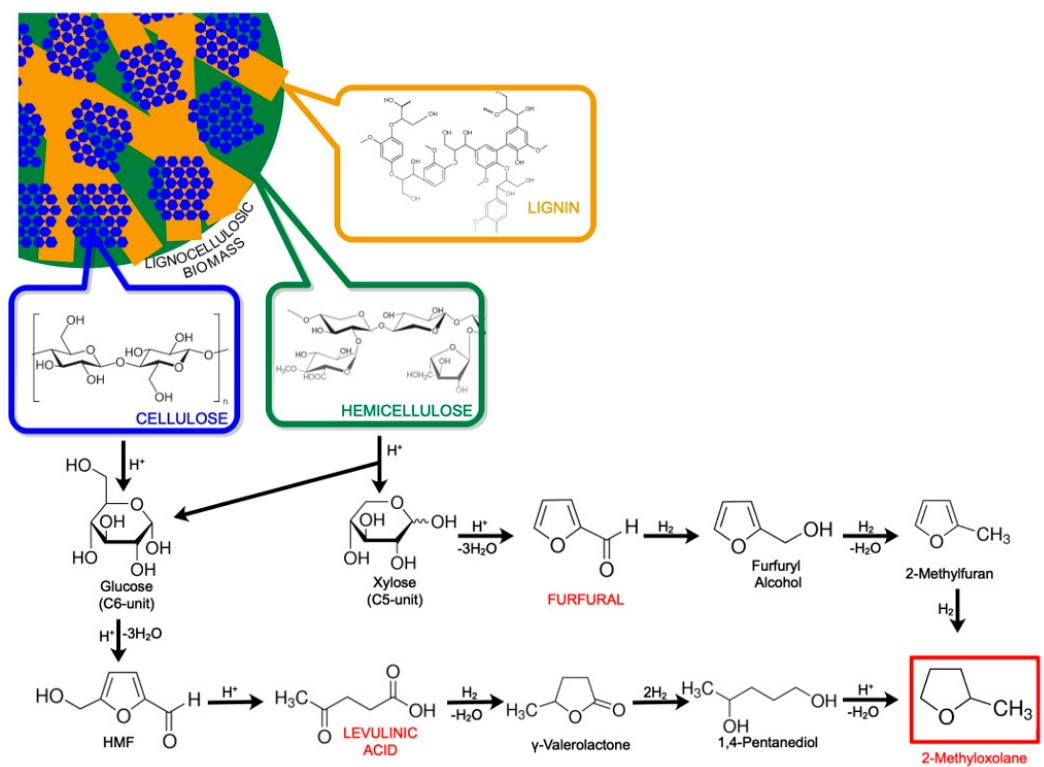
Figure 1. Production of 2-methyloxolane (2-MeOx).